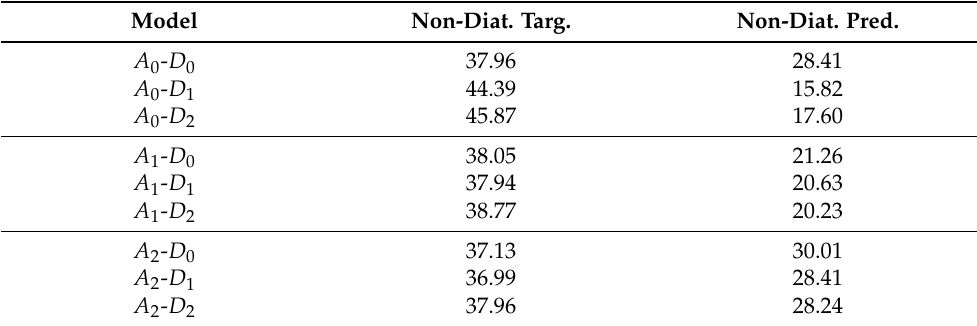
Table 4. Errors occurring when the target is non-diatonic (% of the total number of errors), non- diatonic prediction errors (% of the errors on diatonic targets). Model Non-Diat. Targ. Non-Diat. Pred.